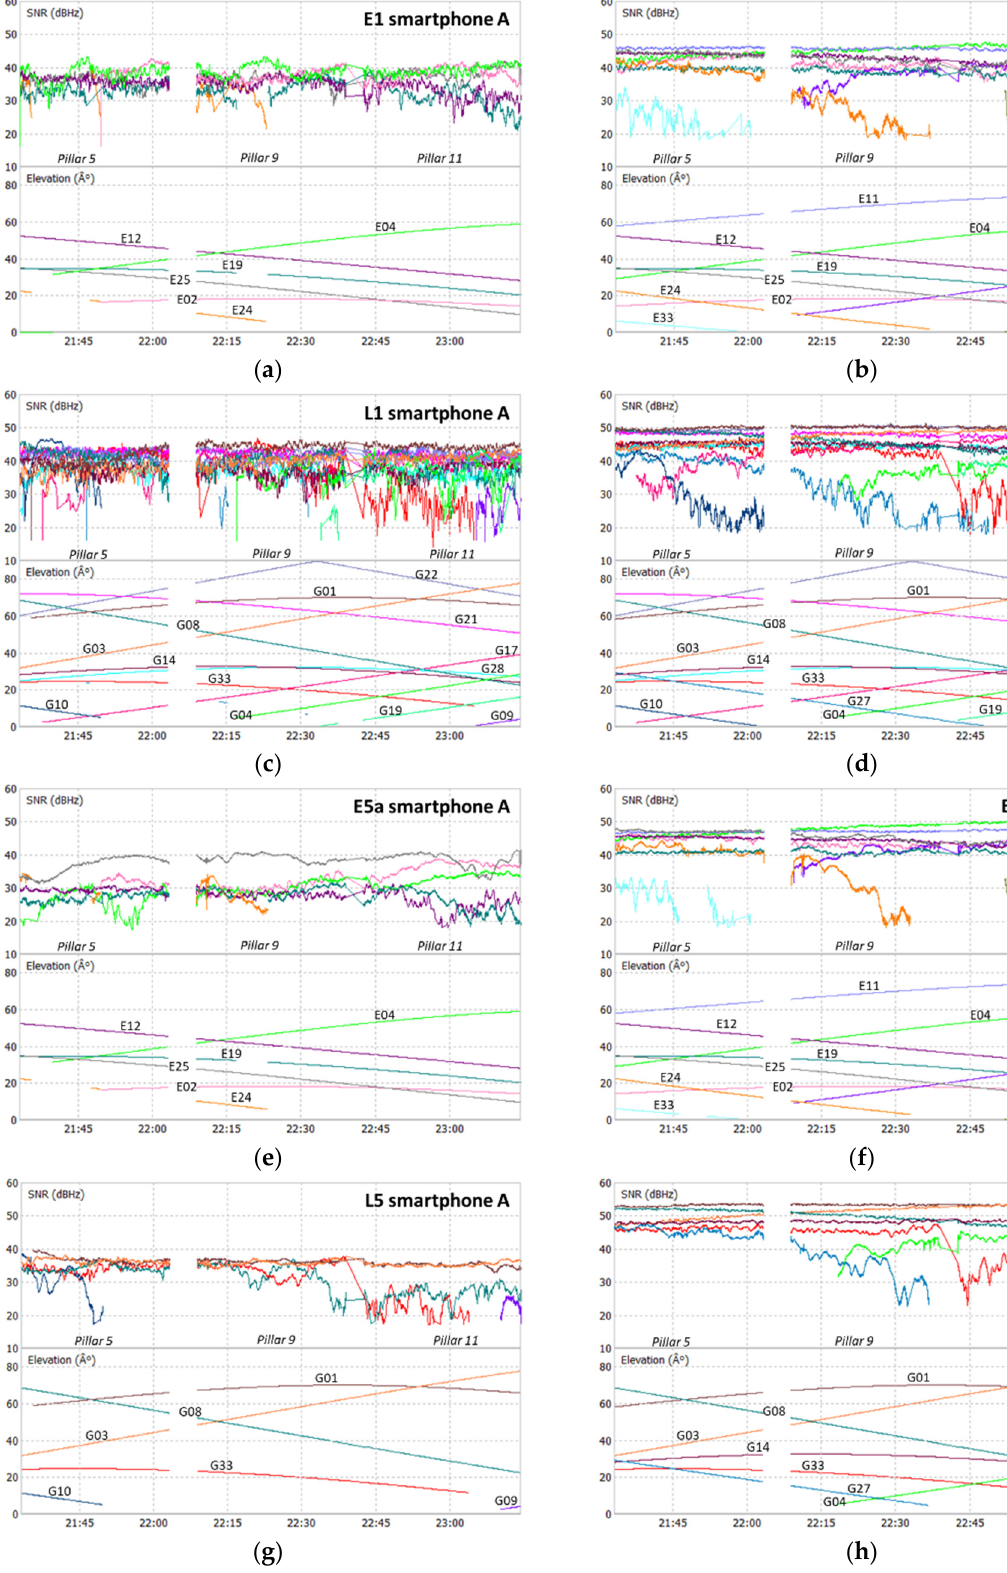
Figure 9. Test 3 SNR: E1 smartphone ( a ) and receiver ( b ); L1 smartphone ( c ) and receiver ( d ); E5a smartphone ( e ) and receiver ( f ); L5 smartphone ( g ) and receiver ( h ).